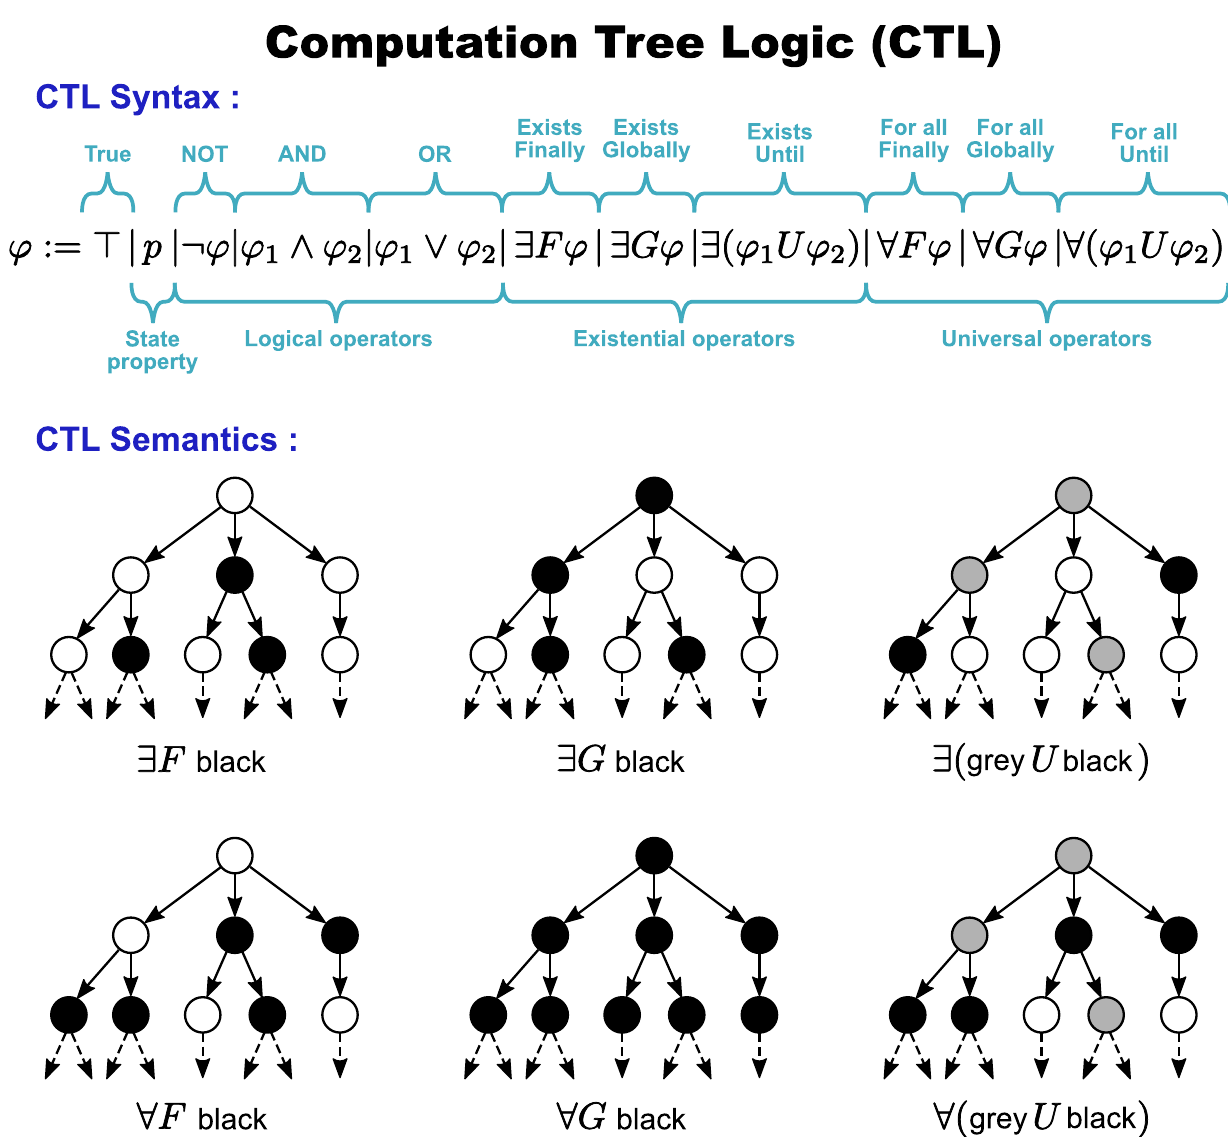
Fig 5. Syntax and semantics of Computation Tree Logic (CTL). The syntax defines how state properties and operators (logical, existential or universal) can be combined into a formula. The semantics describes the meaning of formulas. The semantics presented here is intuitive and given through example CTs satisfying basic CTL formulas. (Adapted from [47].) See [2] for a formal semantics of